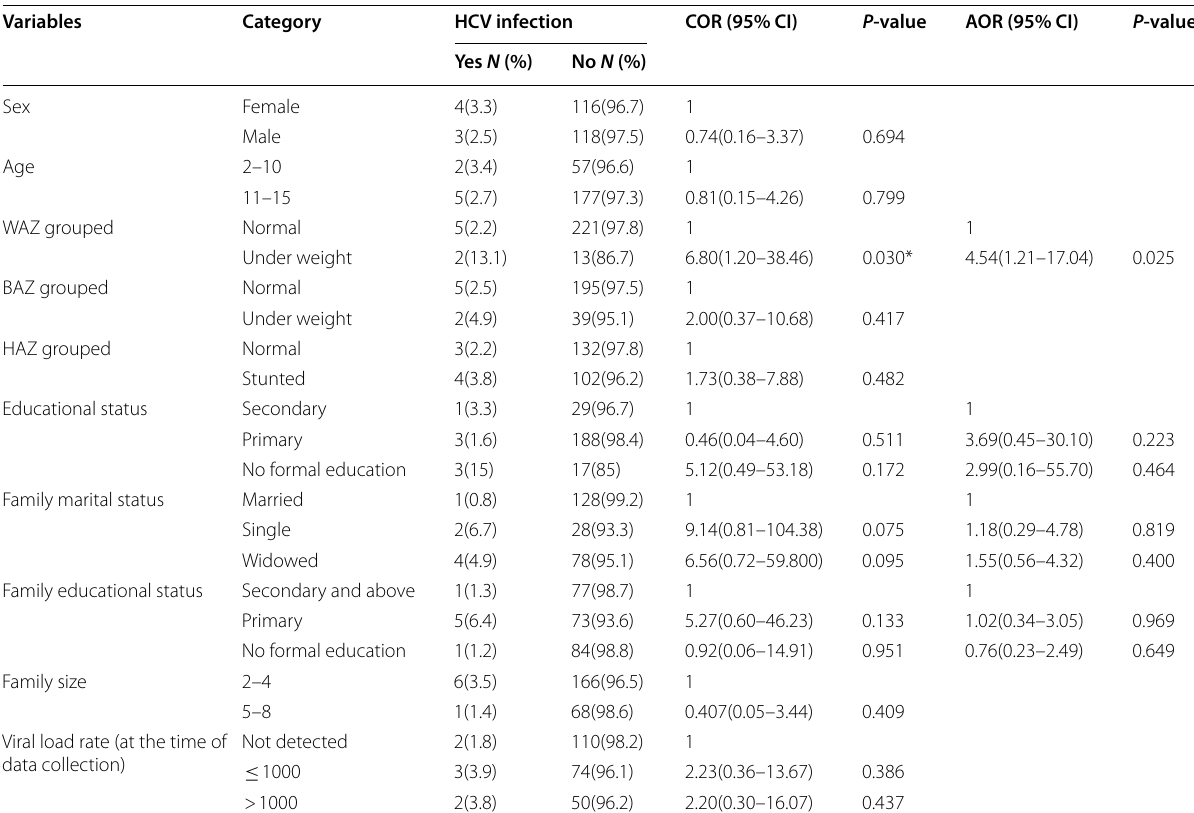
Table 3 Factors associated with HCV infection among HAART-experienced children at the UoGCSH, 2020